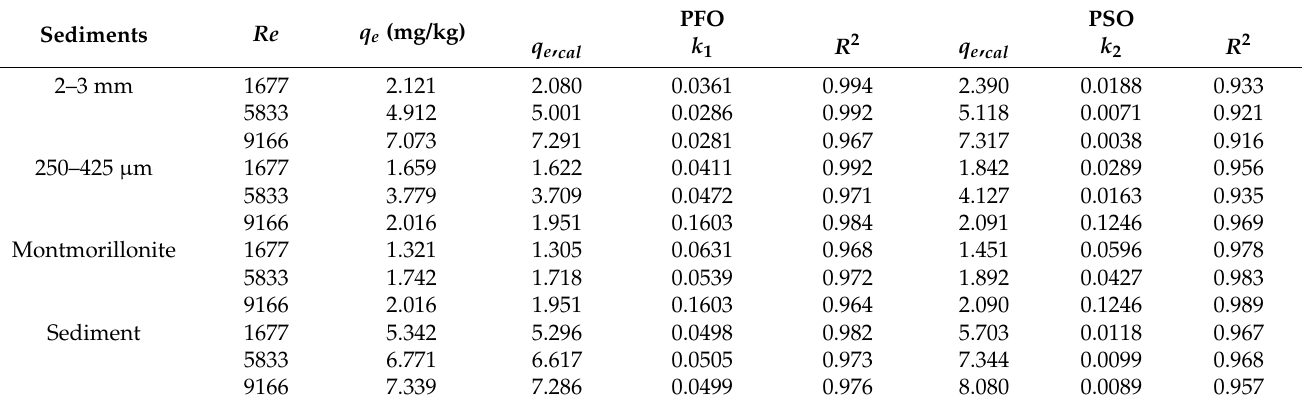
Table 3. Adsorption kinetic parameters of PFO and PSO models of SDZ adsorption on different